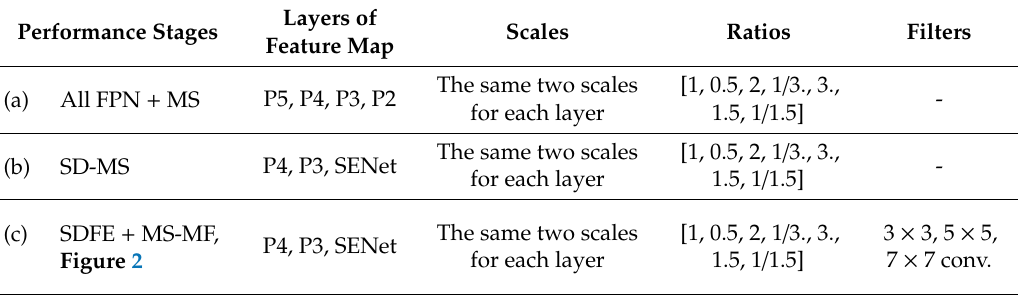
Table 1. Training methods and what is used in each of